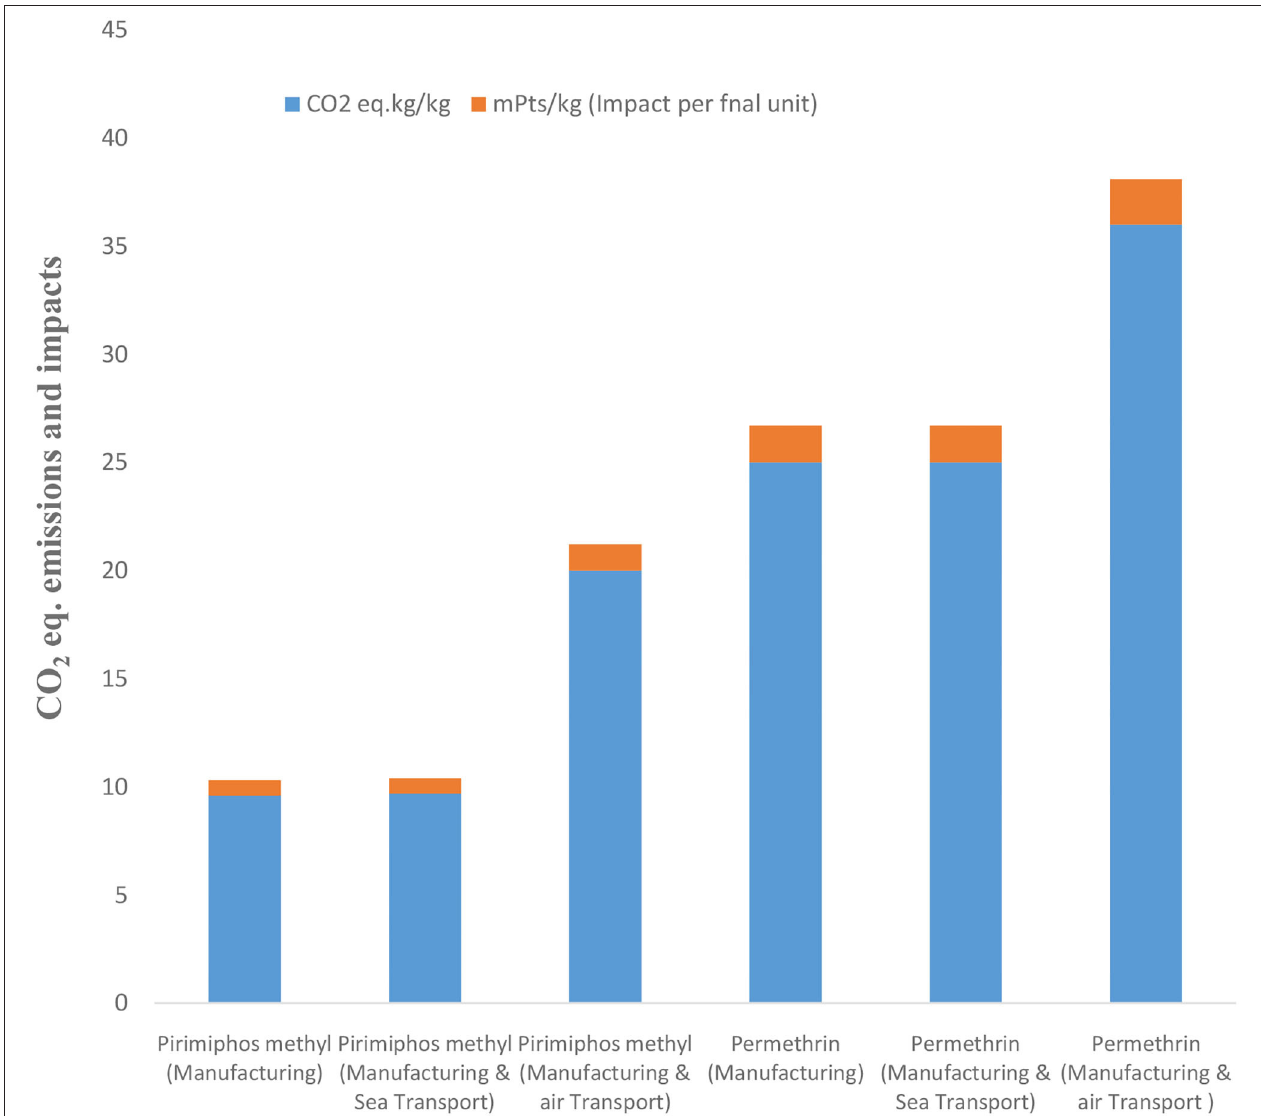
FIGURE 2 | CO 2 equivalent emissions and impacts of pirimiphos-methyl and permethrin during manufacturing and transport (air and sea freight) per kg of insecticide. Impact per FU (mPts) = ecological, resource depletion, and human health damage (generated using Sustainable Minds database, version 3.0, 2013).